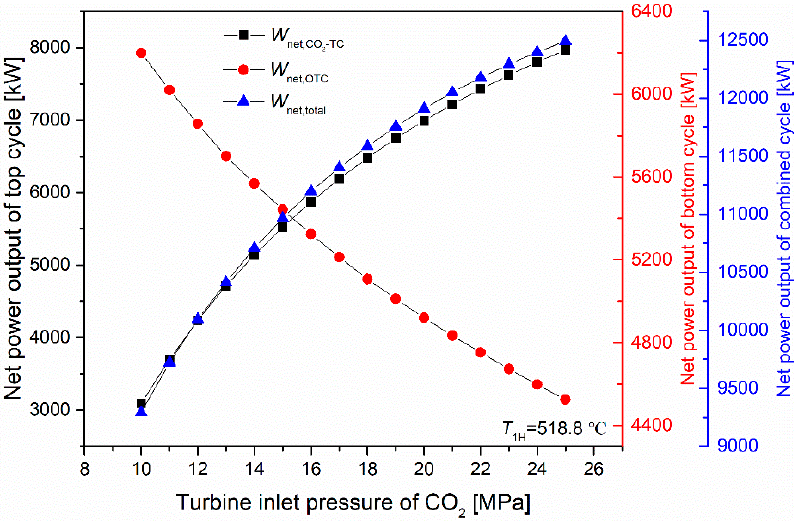
Figure 11. Variations of net power output with turbine inlet pressure of CO 2 for CO 2 -TC/OTC.